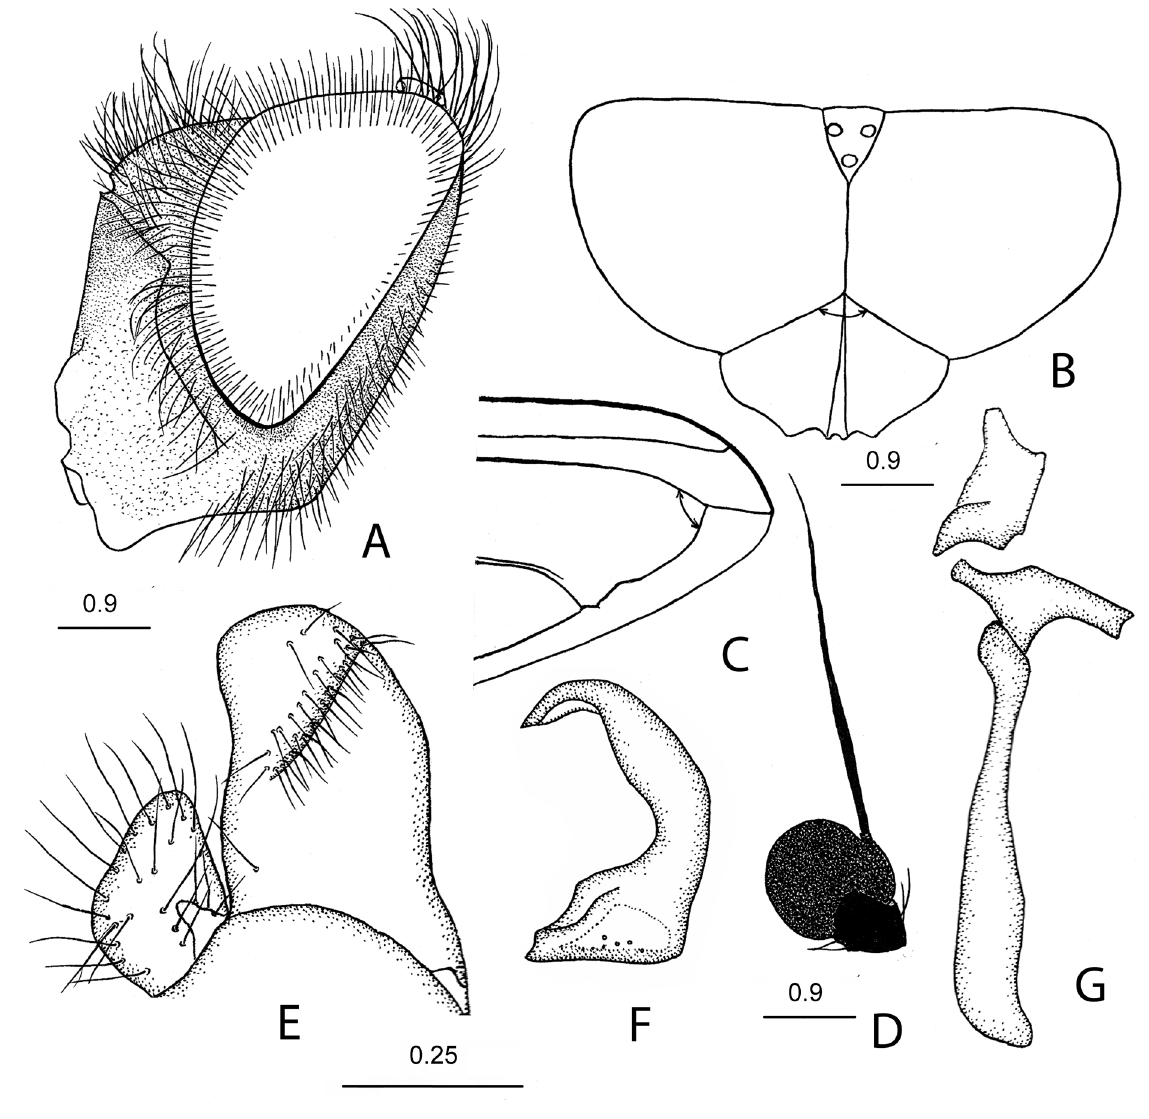
Fig. 45. Cheilosia ( Montanocheila ) nigella sp. nov., holotype, ♂ (NME). A . Head, lateral view. B . Same, dorsal view. C . Tip of wing. D . Antenna, lateral view of pedicel and basoflagellomere. E . Surstylus and gonocercus, lateral view. F . Superior lobe of hypandrium, lateral view. G . Aedeagus and aedeagal apodeme, lateral view. Scale bars indicated in